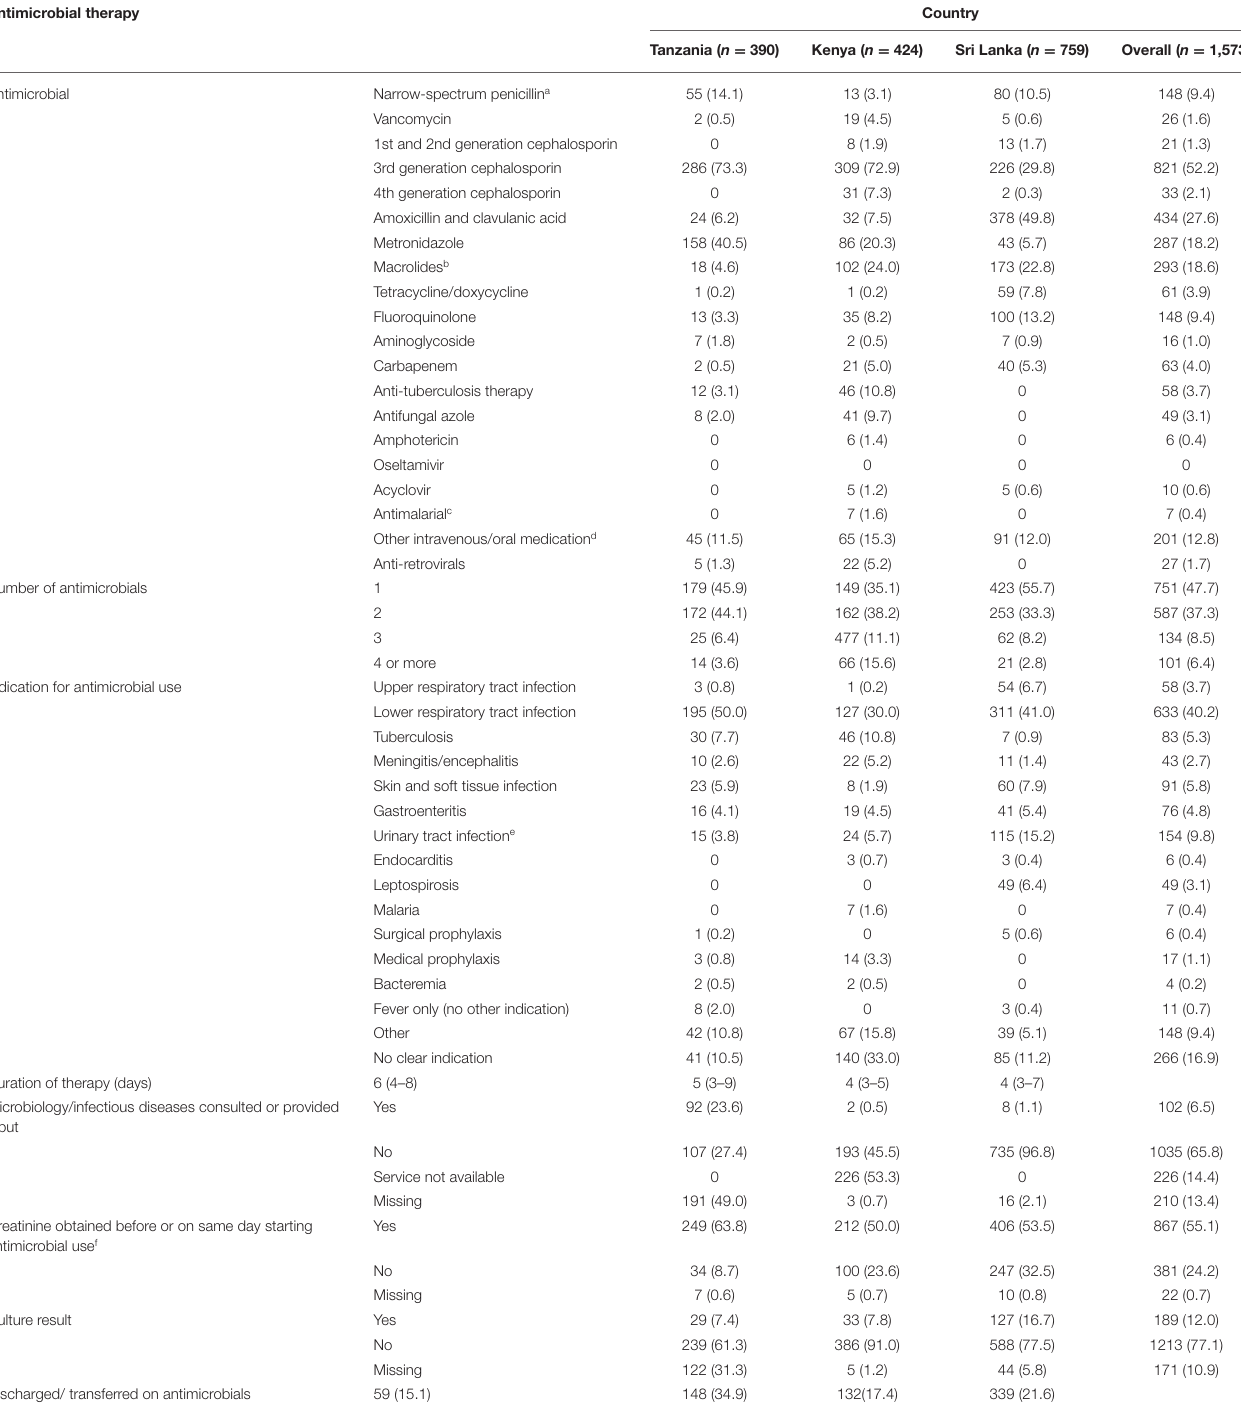
TABLE 2 | Antimicrobial use, indications, and tools to guide therapy across study sites in Tanzania, Kenya, and Sri Lanka ( N = 1,573). Antimicrobial therapy Country